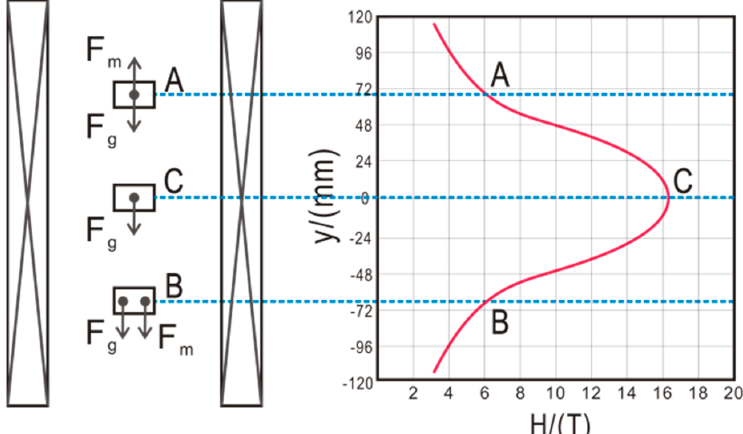
Figure 4. Distribution diagram of the gravitational force and Lorentz force of an object inside the superconducting magnet (JMTA-16T). Positions A, C, and B correspond to µg, 1 g and 2 g, respectively [11].